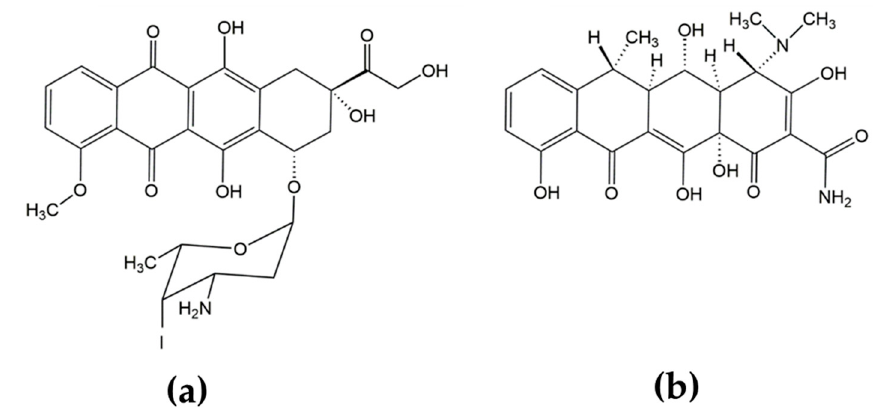
Figure 1. Chemical structures of ( a ) 4 ′ -iodo-4 ′ -deoxydoxorubicin (IDOX) and ( b )